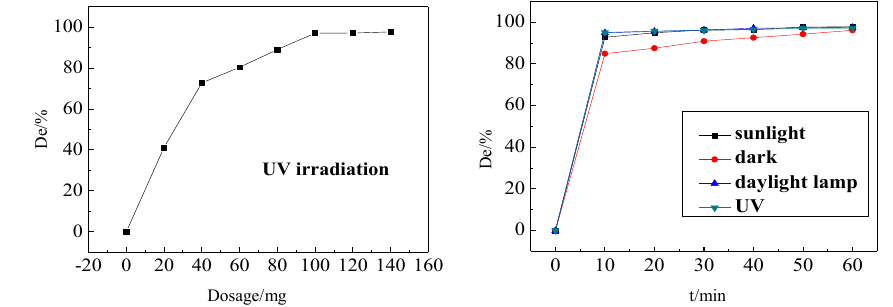
Figure 4 . Relationship between irradiation time and decolorization rate.